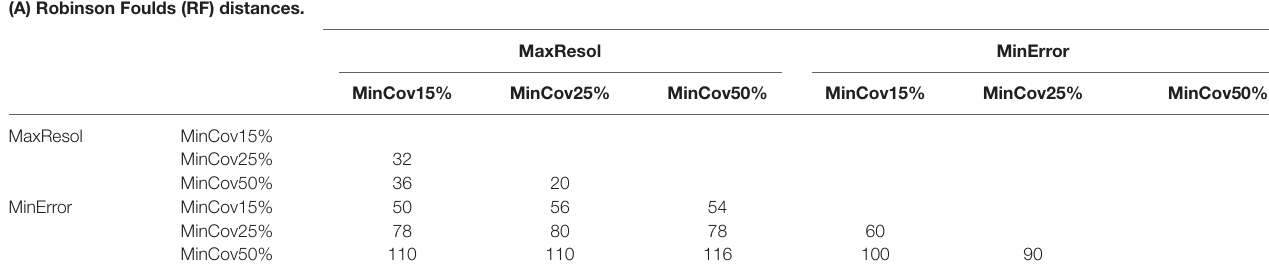
TaBlE 3 | Robinson Foulds (RF) and Branch Score (BSc) distances between Bayesian trees from MinError and MaxResol assemblies estimated in ExaBayes. (a) Robinson Foulds (RF)